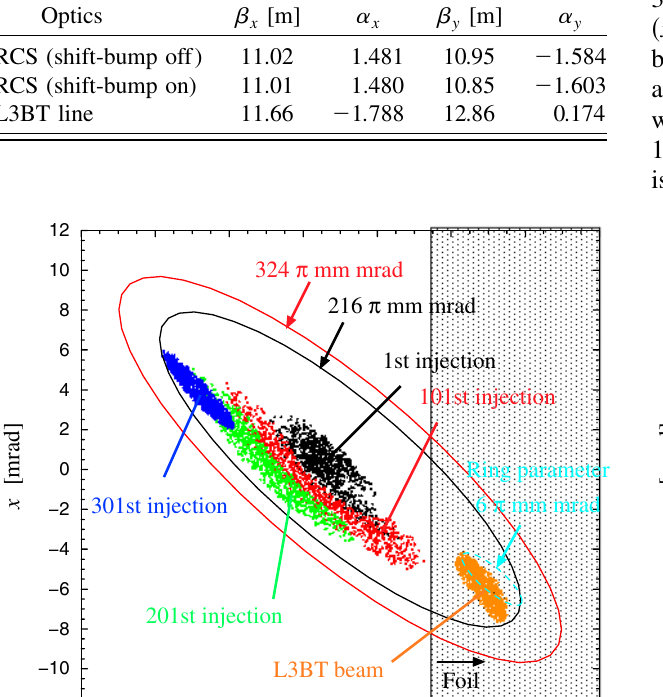
TABLE V. Twiss parameters for the test particle generation at the foil ( s (cid:4) 82 : 113 m ), as calculated by transfer matrices. Optics